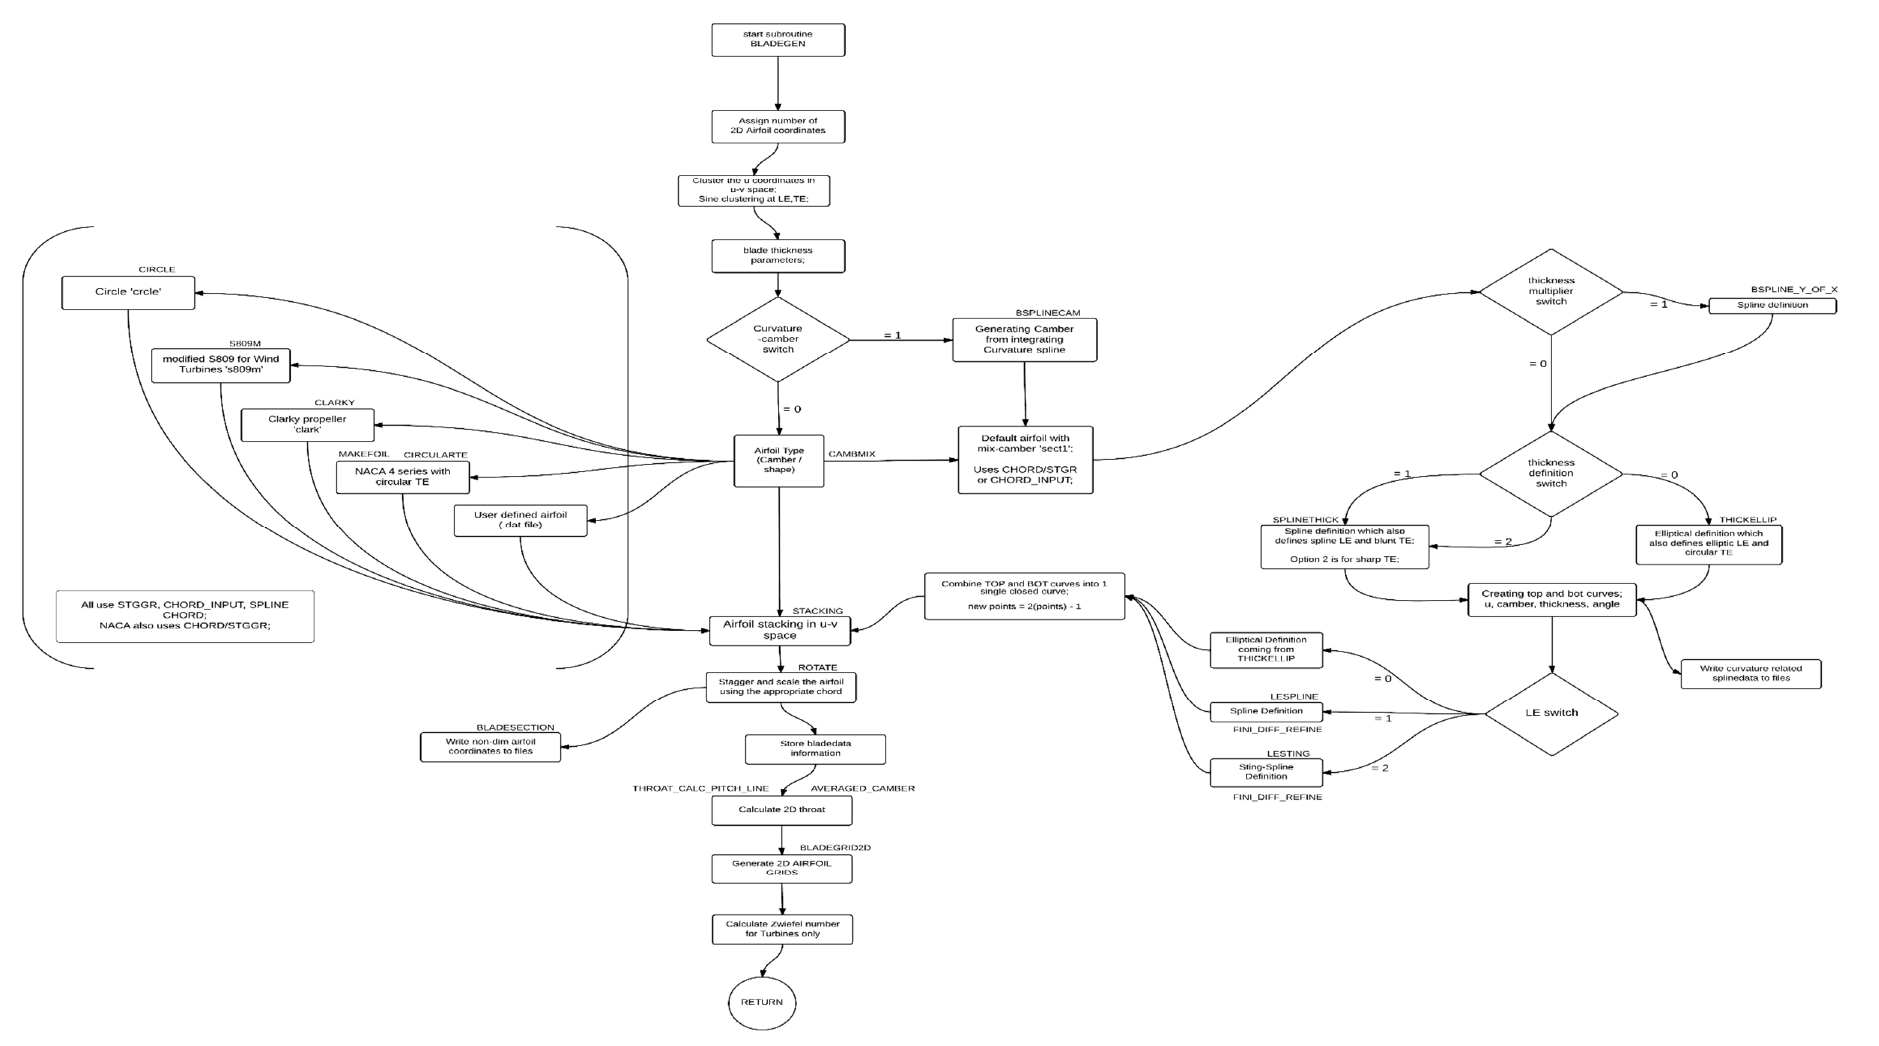
Figure A1. Algorithm for generating 2D airfoils with various options in the tool.